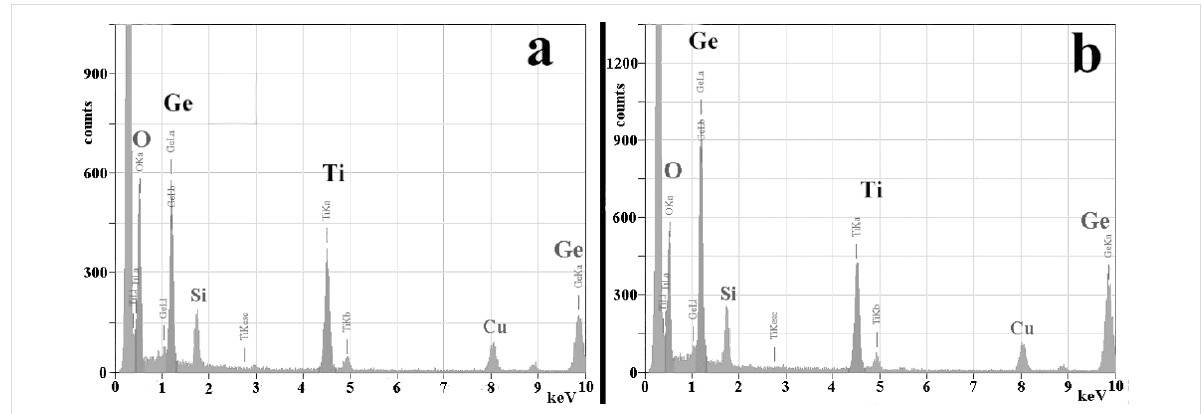
Figure 7: EDX spectra collected on the cross section specimen with an electron beam of 50 nm diameter. (a) Spectrum of the laser-modified layer, and (b) spectrum from a similar specimen area located in the middle of the GeTiO film, where the amorphous structure is not modified by the laser pulse action. The Cu signal comes from the Cu grid and Si peak is due to the redeposition during the ion thinning process.